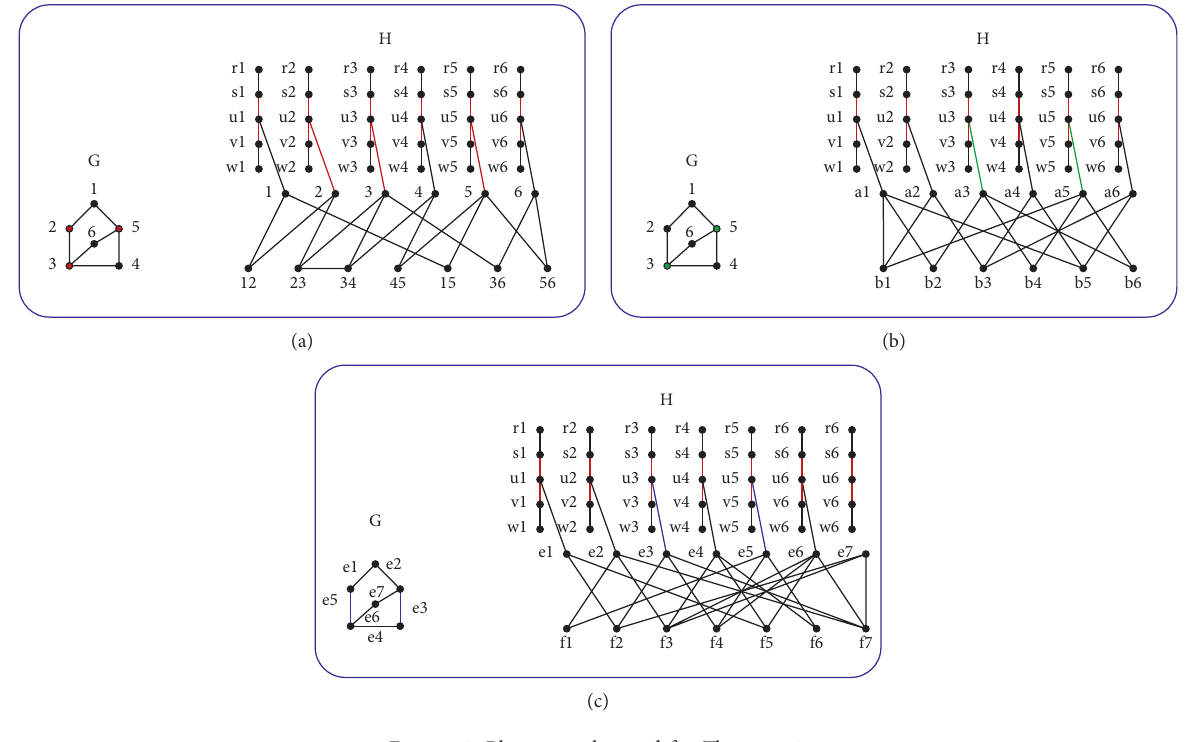
Figure 1: Planar graphs used for Theorem